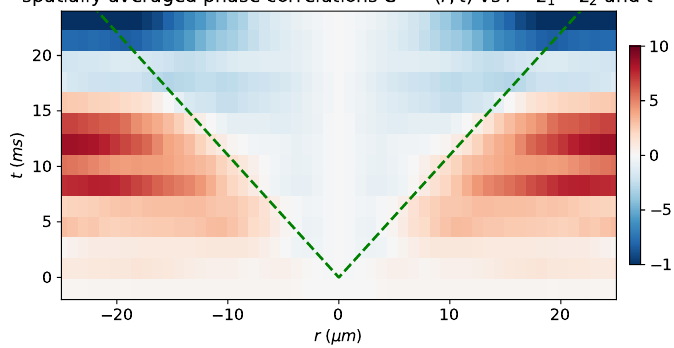
Figure 11: Phase difference correlations C ∆ φ ∆ φ ( z , z , t ) averaged over the mean 1 2 + z ) / 2 and plotted as a function of the distance r = | z − z | and position z = ( z 1 2 1 2 time t . The presence of a light-cone shape which separates the outside region where correlations are largely flat as initially from the inside region where they almost instantly switch to their equilibrium values is clearly visible (see also Ref. [ 41 ] for a detailed discussion). The dashed green lines correspond to the theoretical estimate for the sound velocity as captured by Eq. (58). The averaging, which is done over all pairs of points at the same distance r in the middle region of the system, i.e., along lines parallel to the diagonal of the phase covariance matrix, serves to reduce the statistical fluctuations. At a given time, the middle region agrees with the dynamics in a thermodynamically large system. After time t ∼ 15ms, phase correlations in the middle region of the system start being causally connected to the edges of the system and the dynamics is affected by finite size and boundary